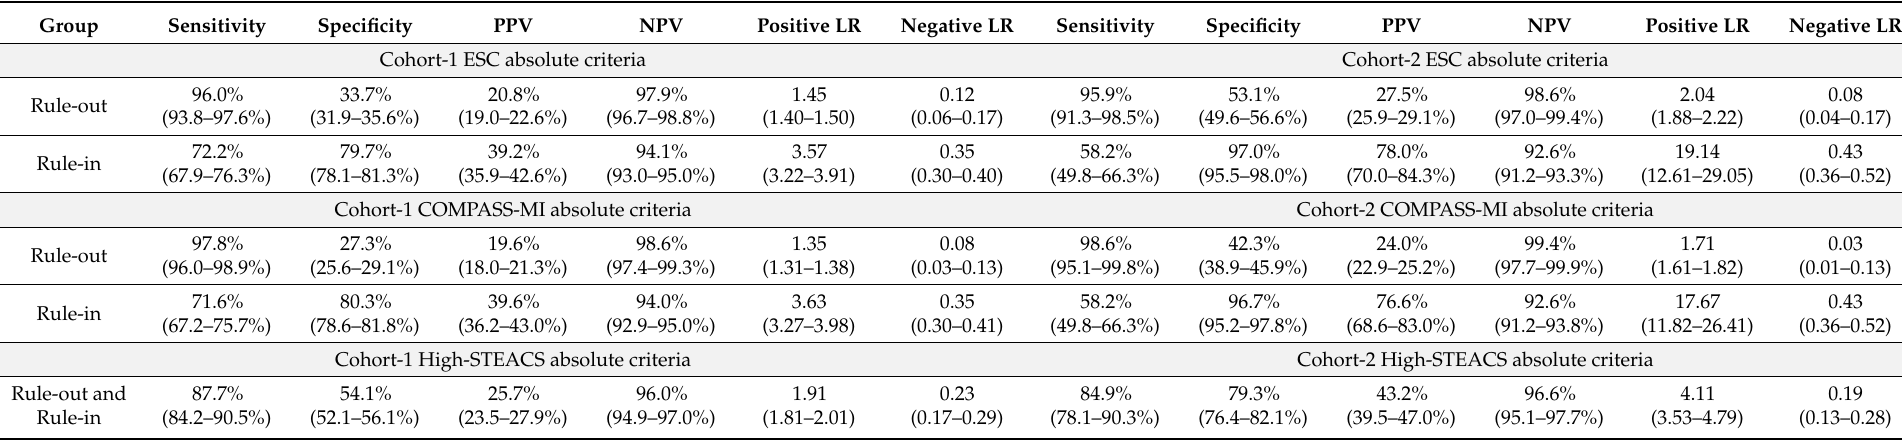
Table 4. Diagnostic performance of the different algorithms for death or MI at 30 days in the two ED